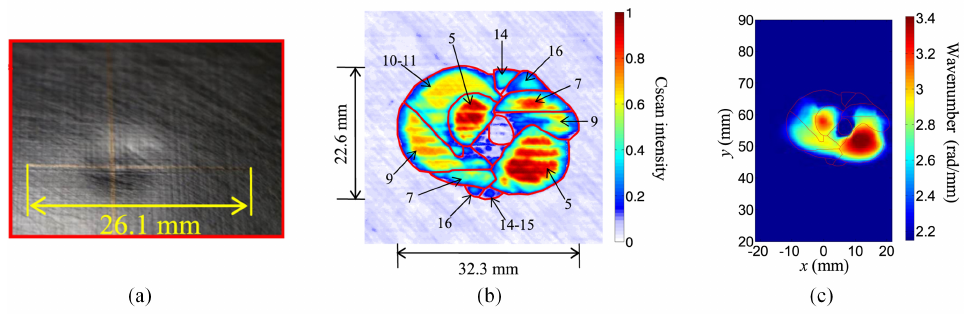
Figure 7. Comparison of composite delamination and imaging results [57]. ( a ) Shape of impact damage. ( b ) C-scan imaging (reference). ( c ) LWE